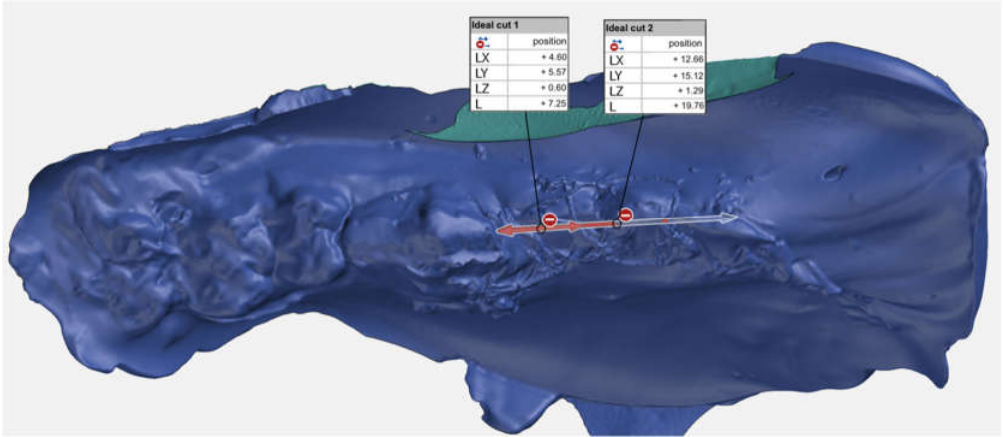
Figure 6. Scan of the immediate postoperative impression with metric analysis of the exact position of the centre of the extraction sockets (shown by the arrows) for later placement of the histological sections.